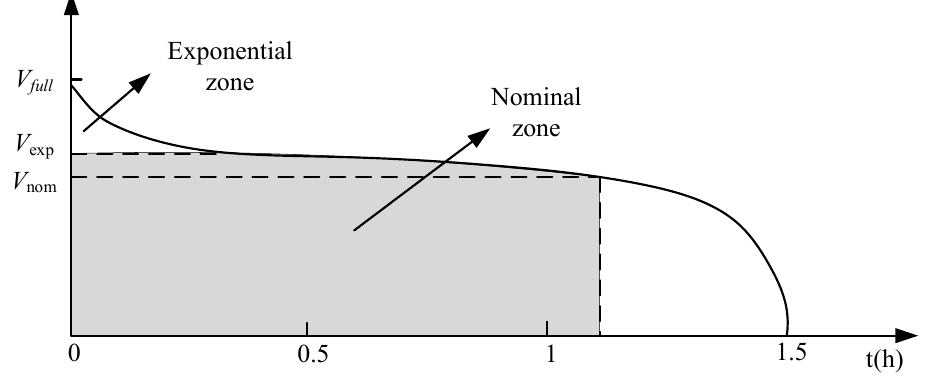
Figure 3. Typical discharging curve for LiB.